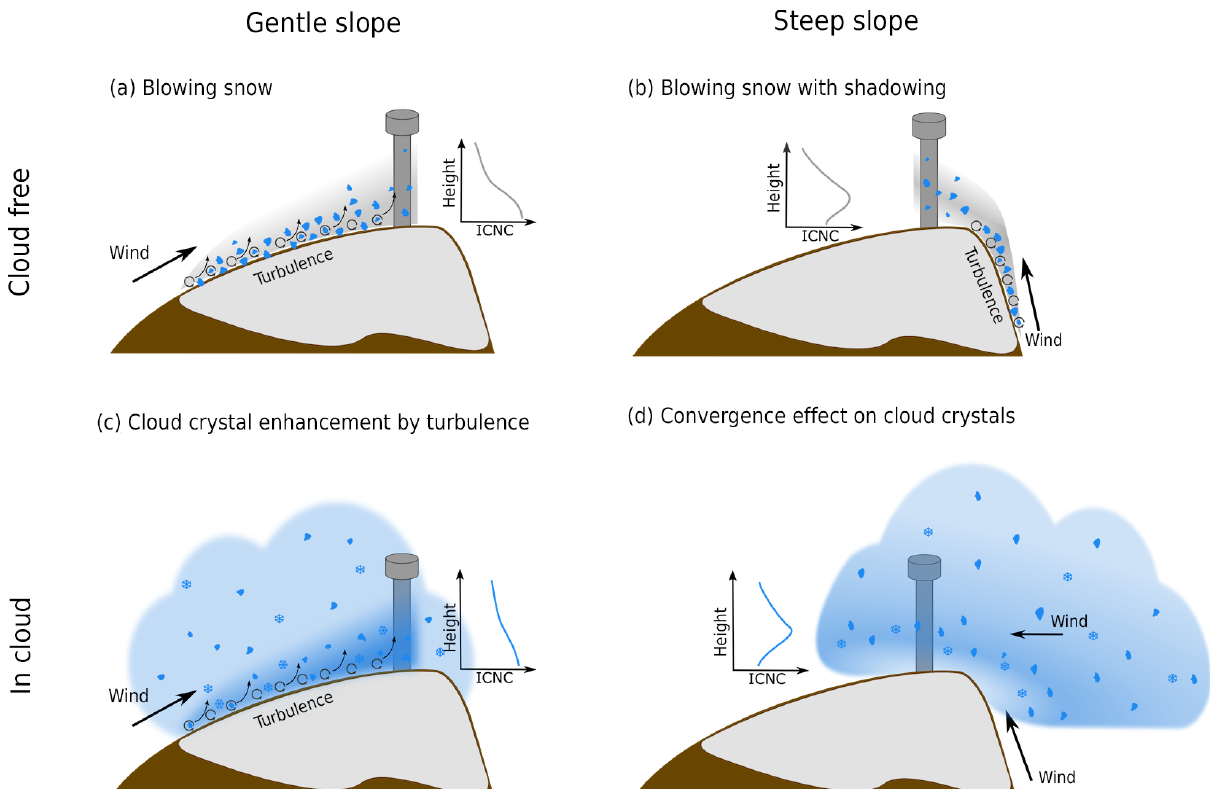
Figure 16. Illustration of surface and near-surface processes that impact the measured ICNC at mountain-top research stations. Panels (a) and (b) illustrate the difference in the height dependence of blowing snow over a surface with a gentle and a convergence effect on the ICNC of regular and irregular ice crystals if a cloud is forced over a